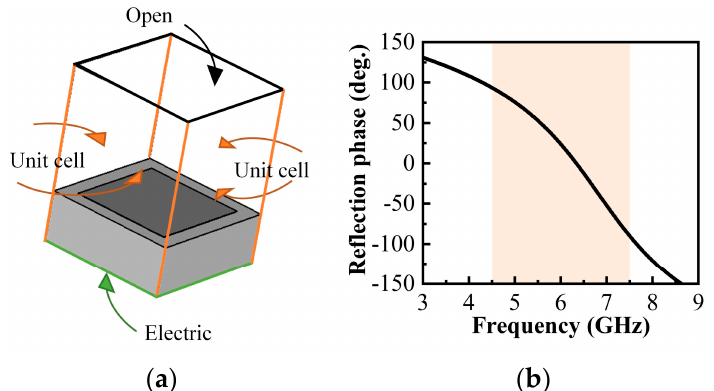
Figure 4. ( a ) The configuration and boundary conditions of the AMC element. ( b ) Simulation reflection phase for the AMC structure.